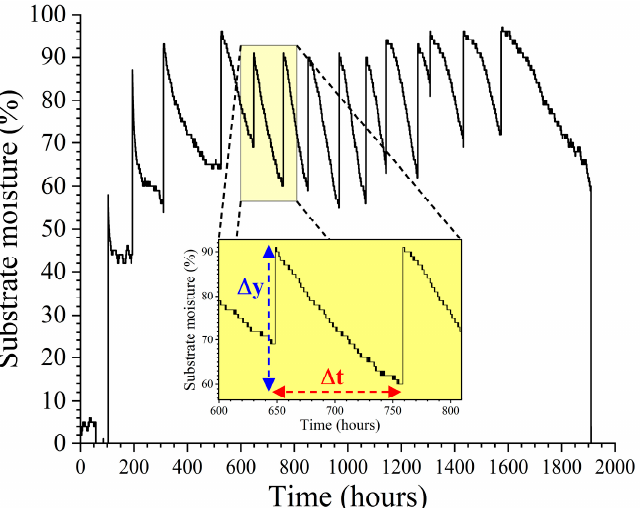
Figure 2. Determination of the plants water consumption. Each peak in the dependence of the substrate moisture on time corresponds to watering the plants in the container. Water consumption (%/hour) of plants was calculated as the average rate of substrate moisture drop between two successive waterings, i.e., v = ∆ y/ ∆ t , where ∆ y is the drop in humidity over time ∆ t . The same pattern of soil moisture dependence on time is observed under the potato growth in the field conditions with arti fi cial irrigation in arid area [26].